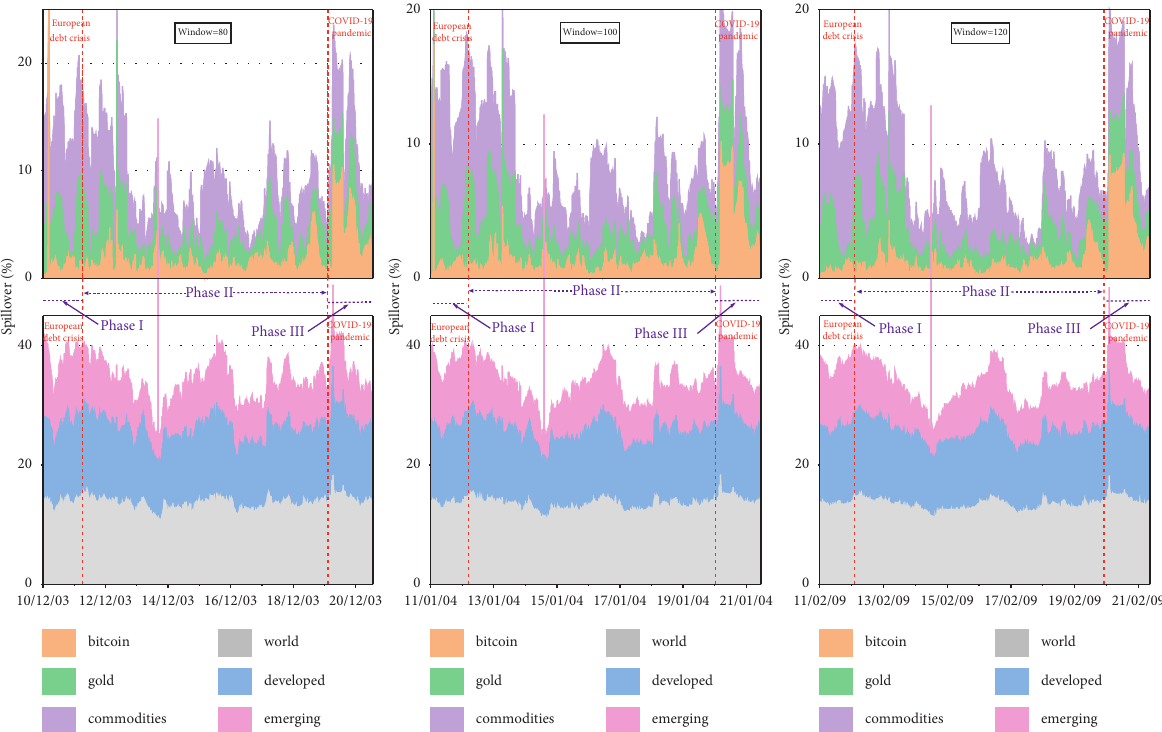
Figure 7: Dynamic net spillover to others with different rolling windows. The red dotted line defines the time points that distinguish three sample phases. The three window sizes plot the dynamic return total spillover measures on the 80 (the sample period for returns is from December 8, 2010, to June 23, 2021), 100 (the sample period for returns is from January 4, 2011, to June 23, 2021), and 120 (the sample period for returns is from February 9, 2011, to June 23, 2021). All abbreviations are as follows: bitcoin, gold, and commodities indices (com- modities); the world stock index (world); the developed stock index (developed); and the emerging stock index